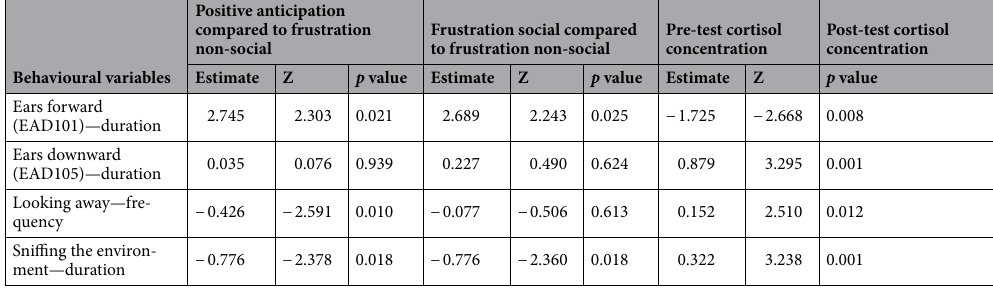
Table 3. Main results of the associations between behavioural variables (frequency and durations) and cortisol concentrations. Results for “sniffing the environment” are related to post-test cortisol